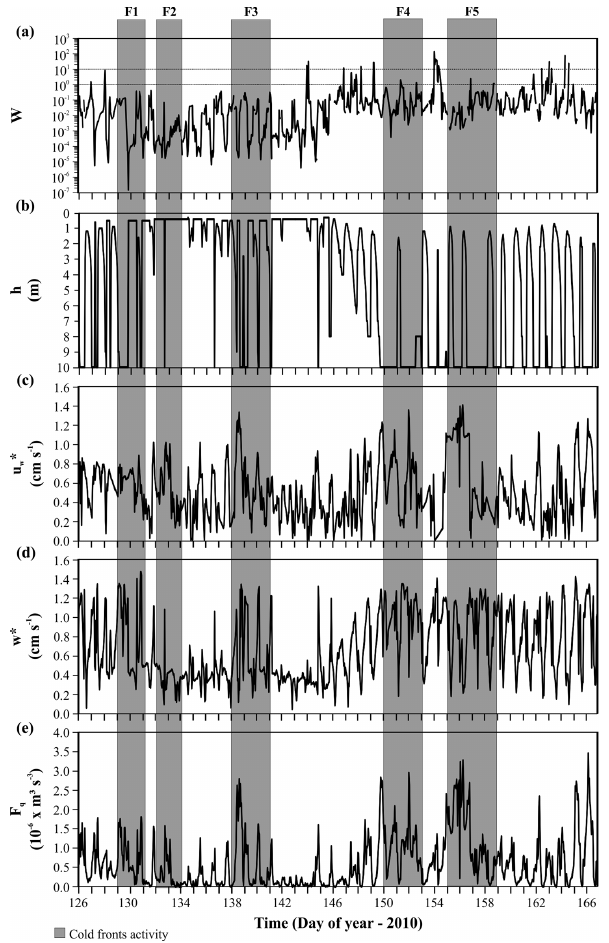
Figure 9. Time series computations of Wedderburn number (a) , DML depth (b) , water shear velocity scale (c) , penetrative entrain- ment velocity scale (d) and energy input (e) .